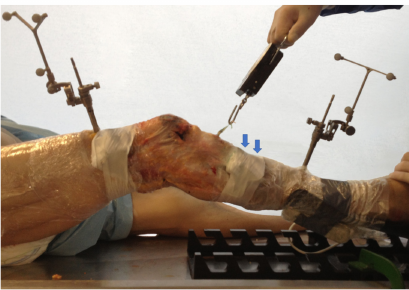
Figure 3. Setting of a cadaveric investigation using non-invasive inertial sensor (blue